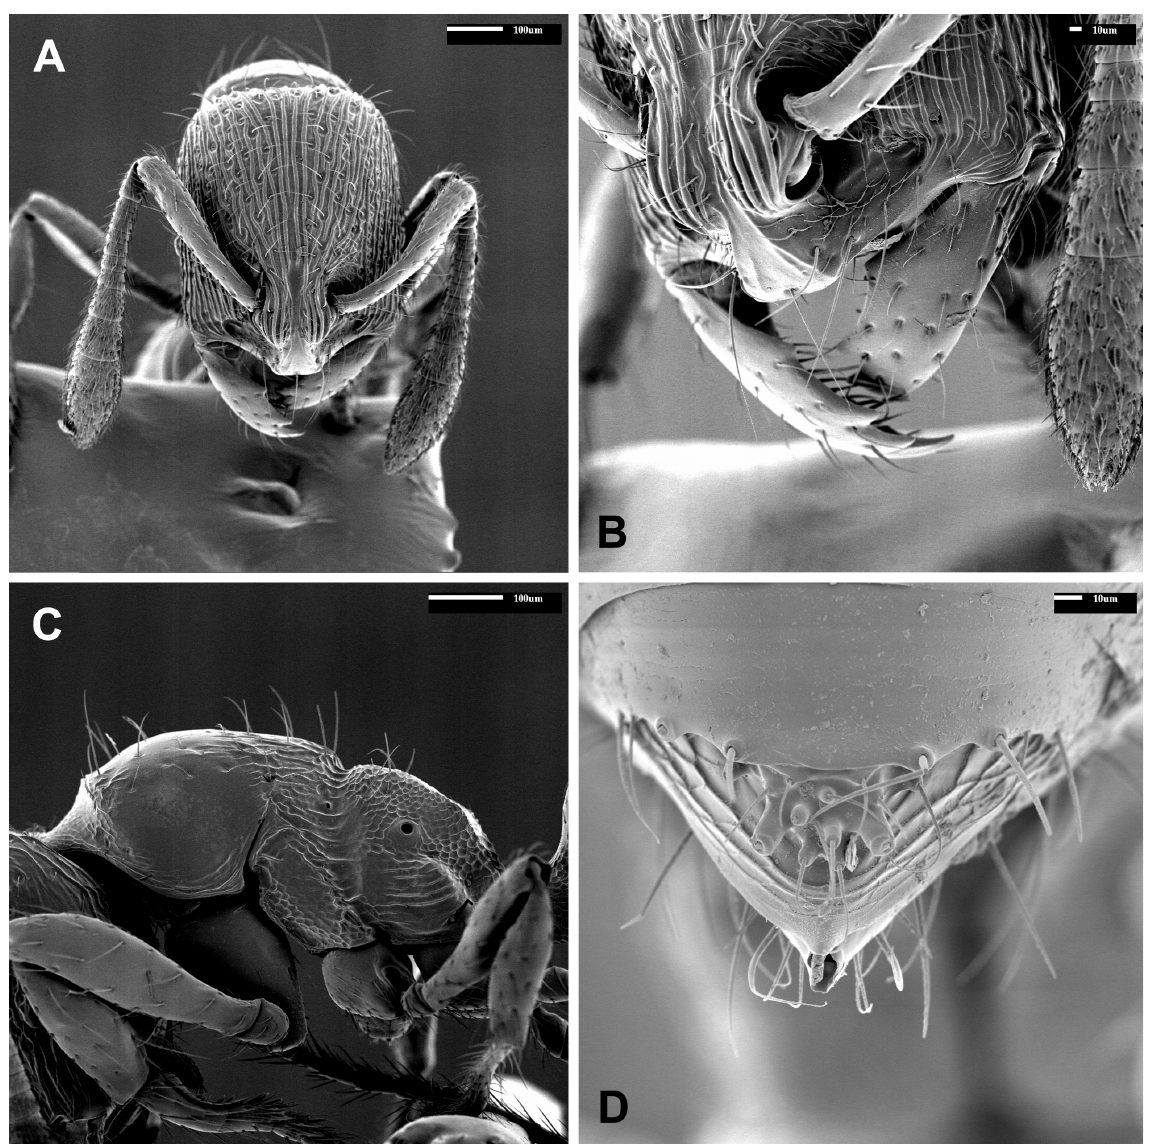
Fig. 1. Kempfidris inusualis (Fernández, 2007) comb. nov., worker from Benjamin Constant, Amazon, Brazil (ICN). SEM photographs. A . Head in full face view. B . Head in dorsal oblique view. C . Mesosoma in lateral view. D . Apex of metasoma showing the cylindrical